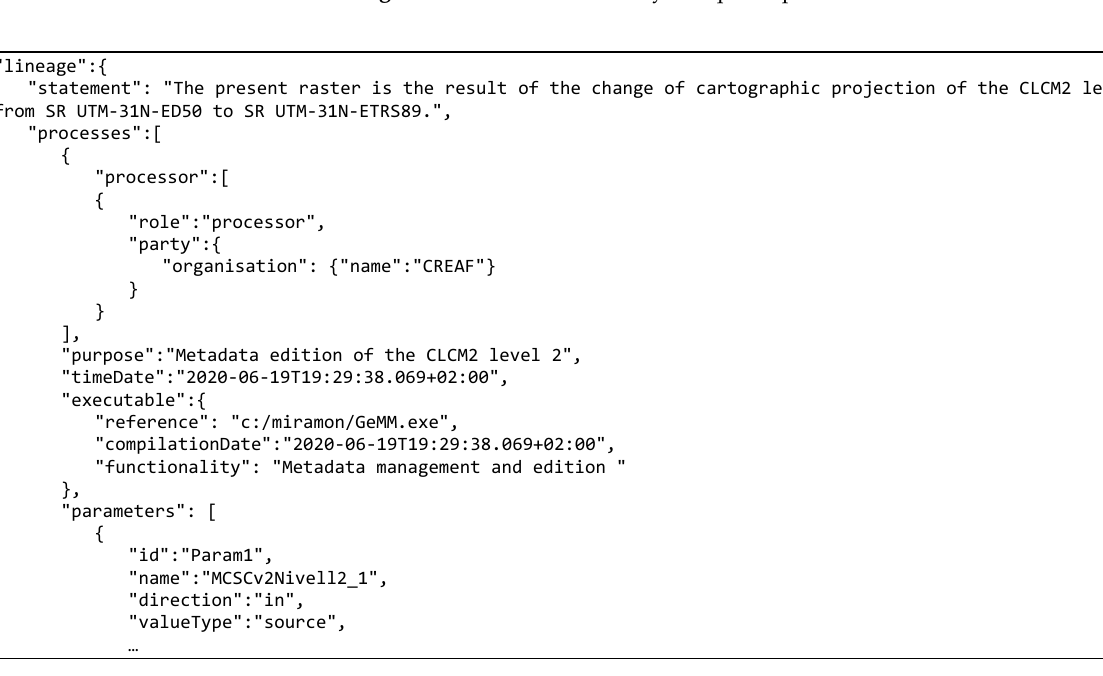
Figure 7. A CSW GetRecordById request operation.